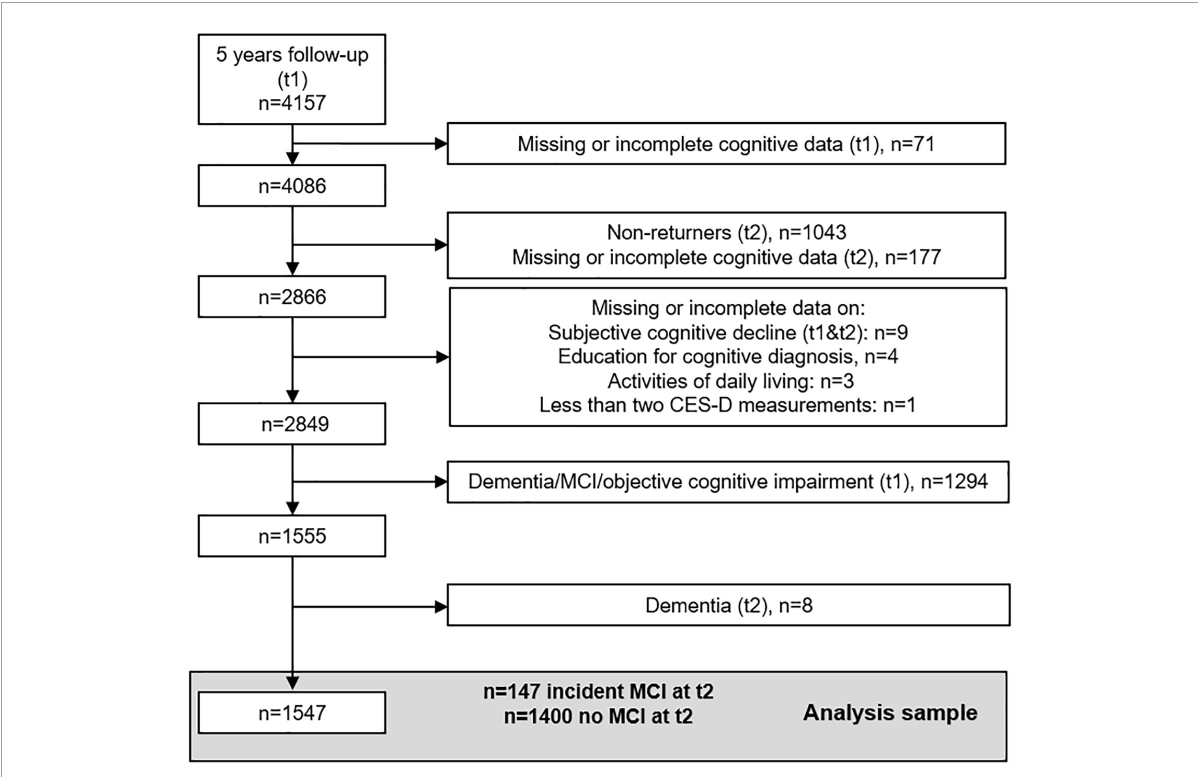
FIGURE2 Sample flowchart for the present study. MCI, mild cognitive impairment; t1, first follow-up examination; t2, second follow-up